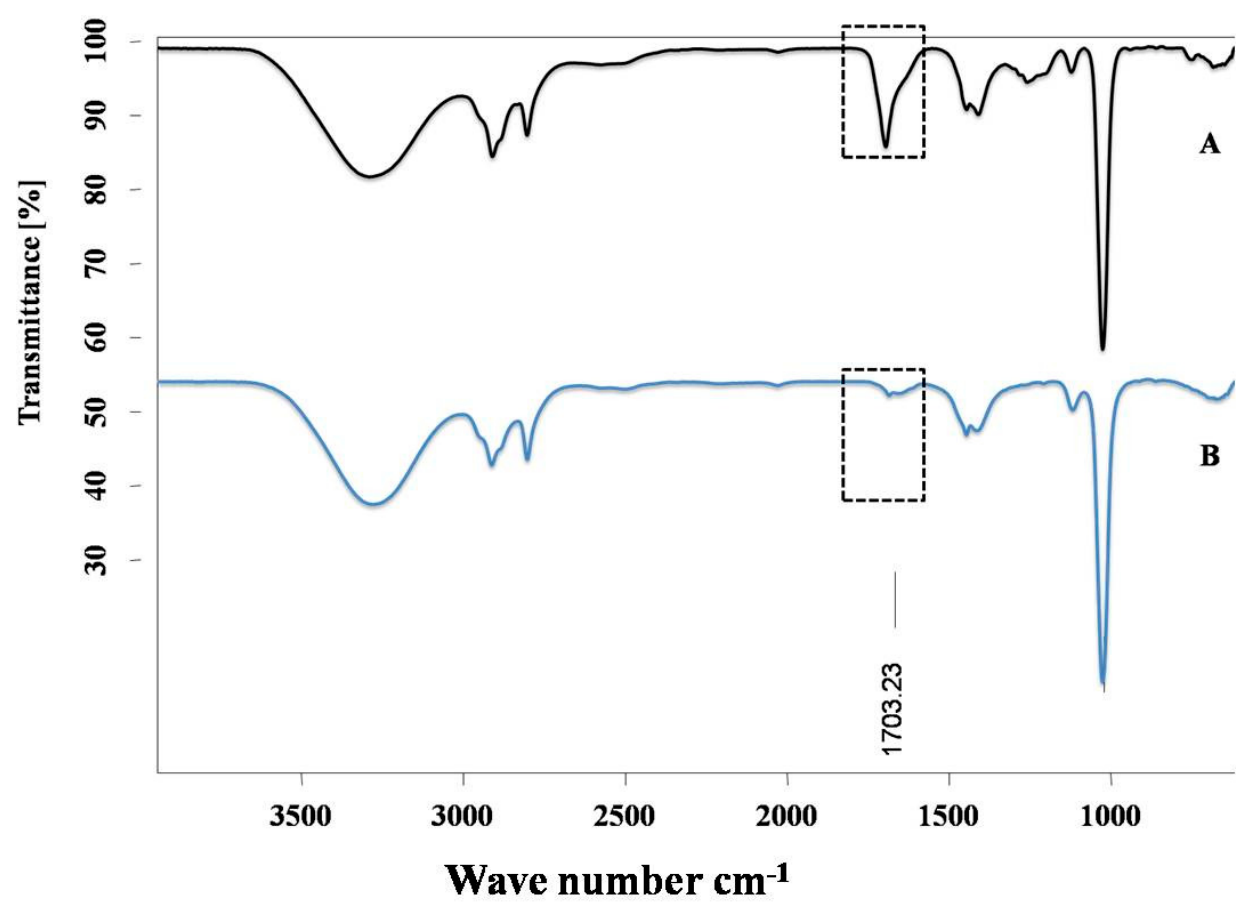
Figure 3. IR spectra of ( A ) ALA and ( B ) ALA with Cu. Carbonyl (C=O) peak present in ALA comes at 1703 cm − 1 and almost disappears after the addition of Cu, suggesting that the carbonyl group might be responsible for metal ion ligand complex formation. The dotted box indicates changes in the peaks.